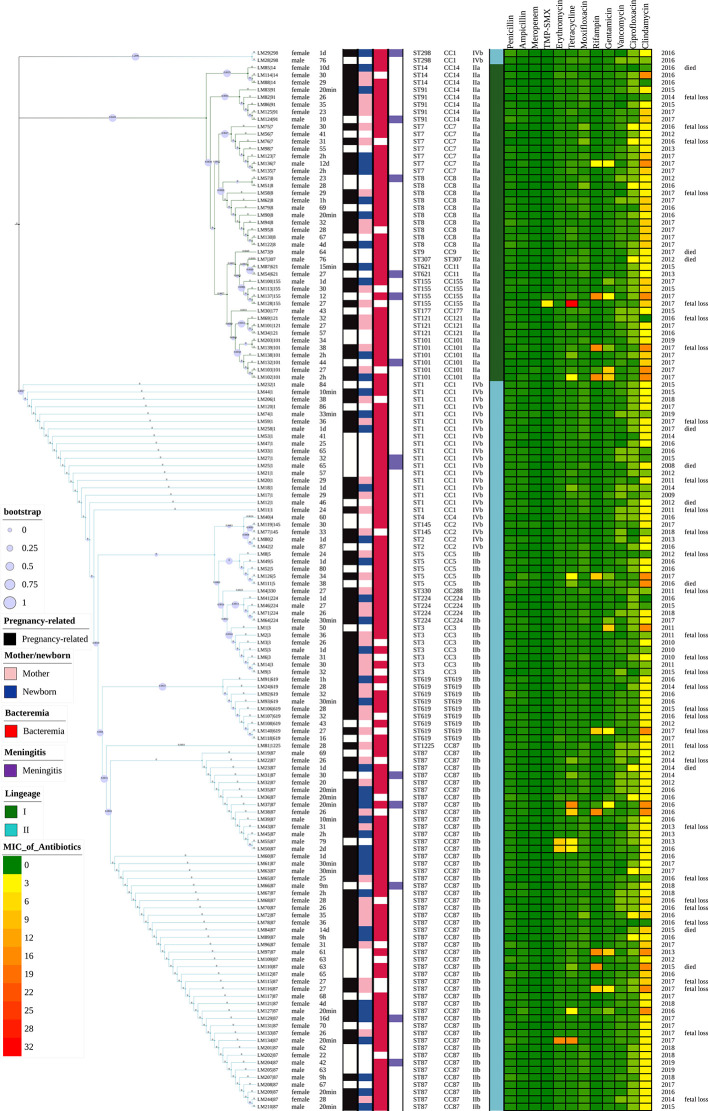
Representation of analysis and phylogeny of L. monocytogenes strains collected from patients with listeriosis in 15 cities/provinces in China. A complete picture of the phylogeny was constructed by the maximum likelihood method using seven housekeeping genes of multilocus sequence typing (MLST) of the above strains using MEGA (Version 10.0.5) and iTOL v4. from left to right: 1 Sex; 2 Age; 3 Pregnancy or not; 4 Mother/newborn (both mothers and newborns were infected in the cases of LM44, 39, 35); 5 Bacteremia; 6 Meningitis; 7 Sequence types; 8 Clonal complexes; 9 Serogroups; 10 Lineage; 11–22 MICs of 12 antibiotics (µg/ml); 23 Year of isolation of L. monocytogenes strains; 24 Adverse outcomes.